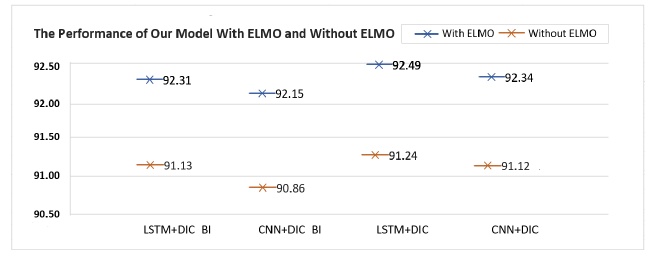
Figure 8. The performance of our model when combined with the ELMo network at the delayed